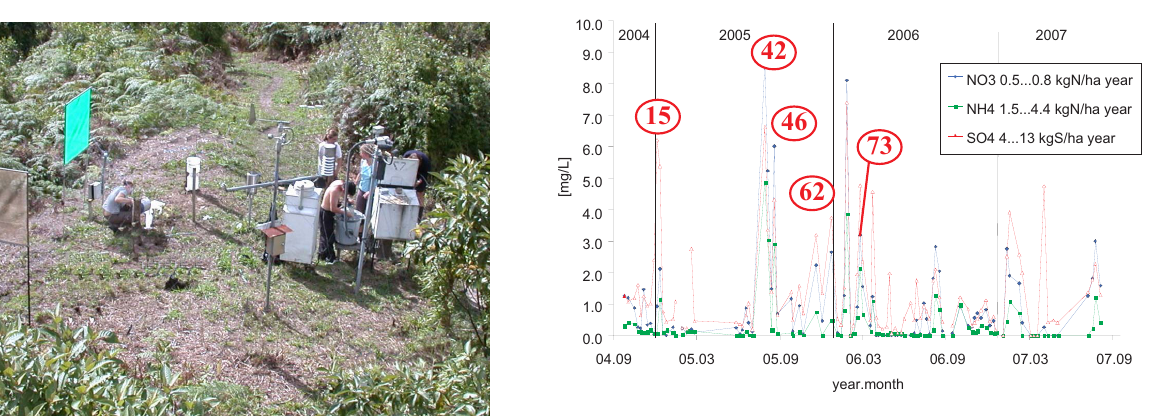
Fig. 3. Ion concentration plots for NO 3 , NH 4 , and SO 4 analysed from weekly fogwater samples collected at El Tiro. Table 1. Stations for rain and fogwater collection.